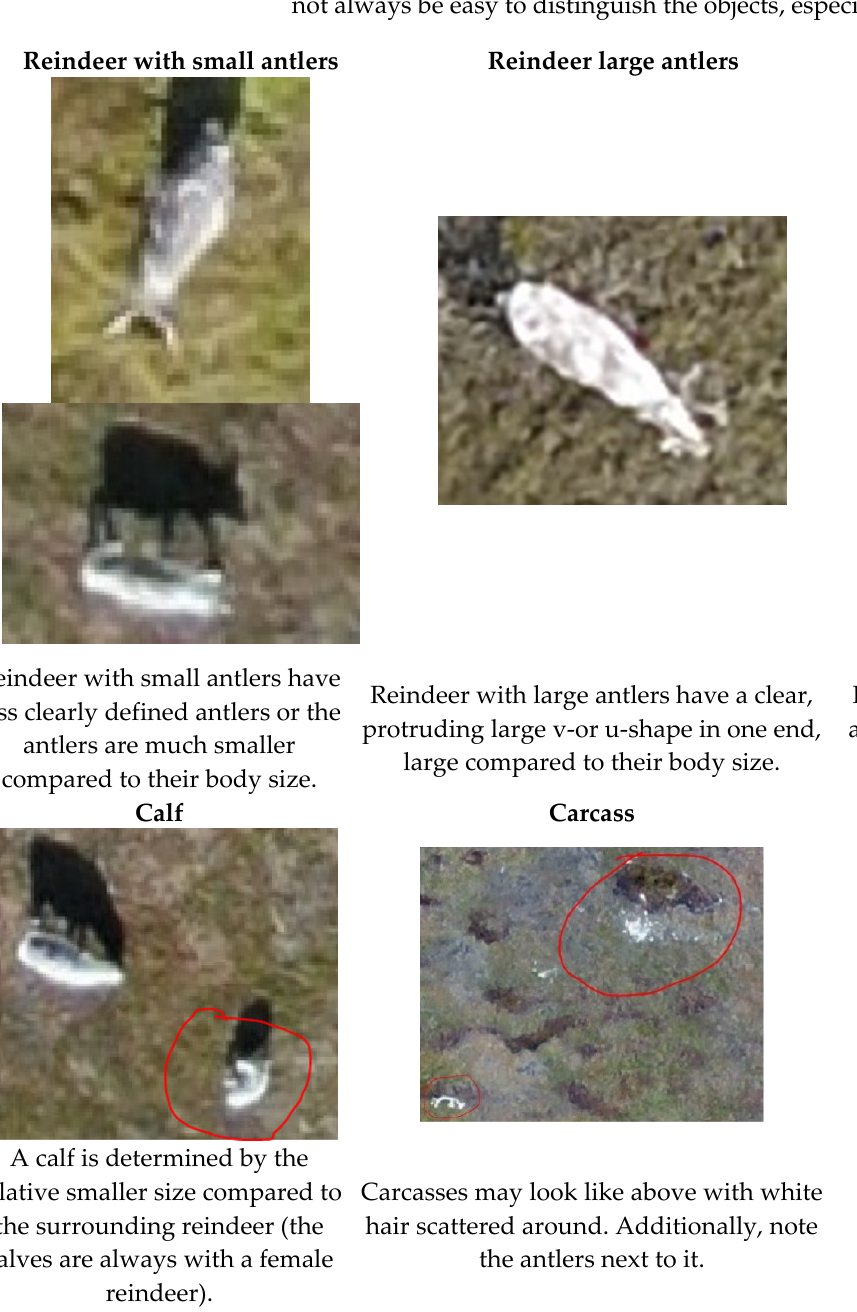
Figure A4. Overview of the five classes to categorise reindeer from drone imagery.